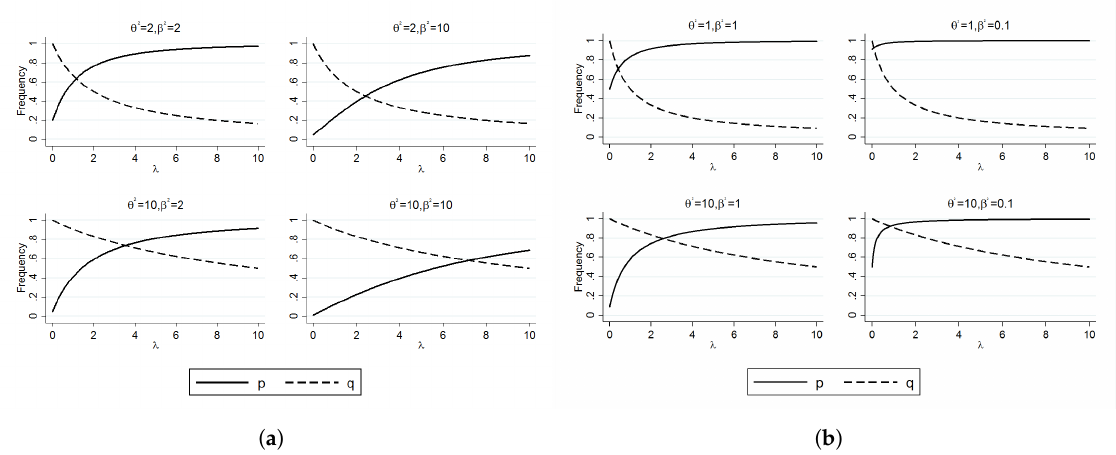
Figure 2. Changes in population frequencies as a function of λ . Subfigures ( a ) and ( b ) assume different values for the bias in socialization parameters: θ and β